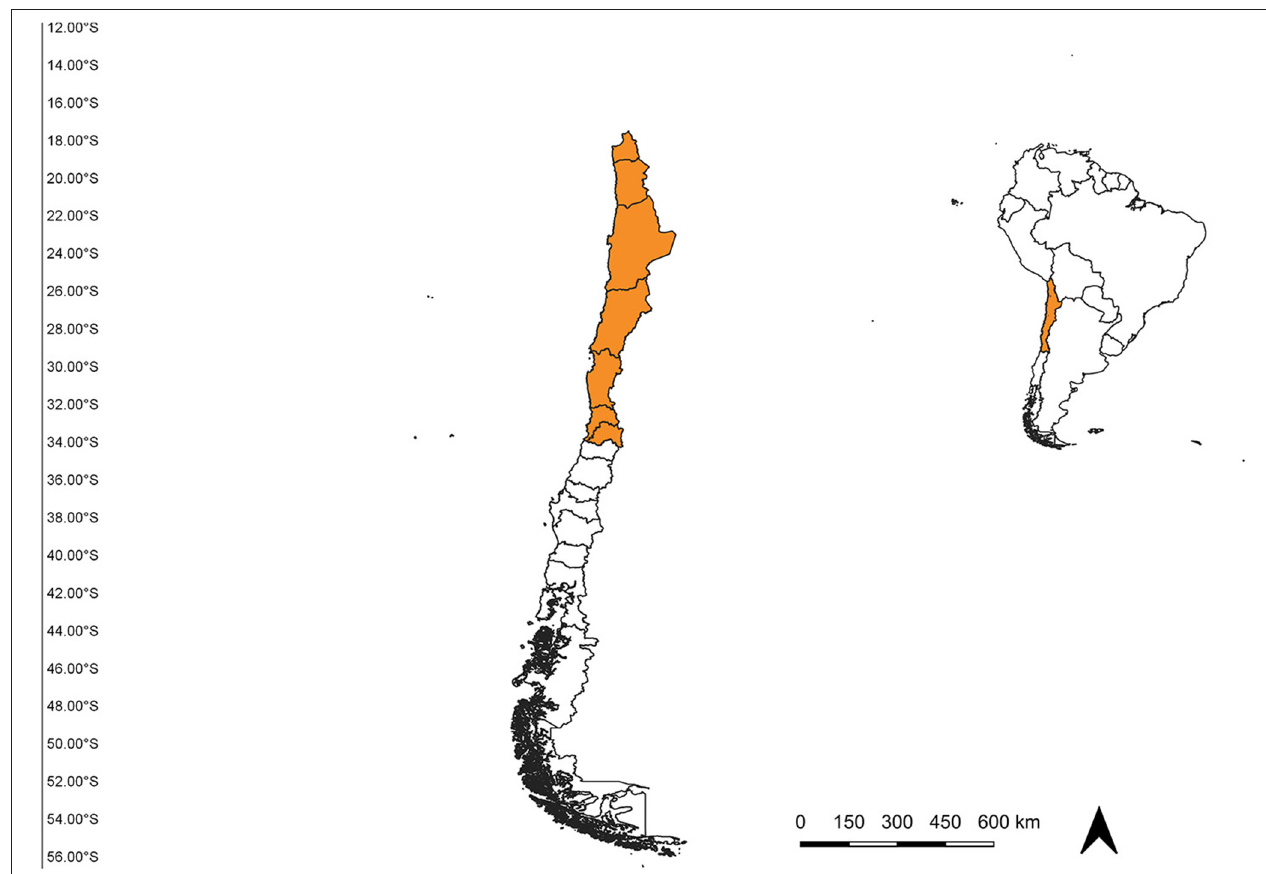
FIGURE 1 | Study area spanning from the Arica region in the north to the Metropolitan region in the south,